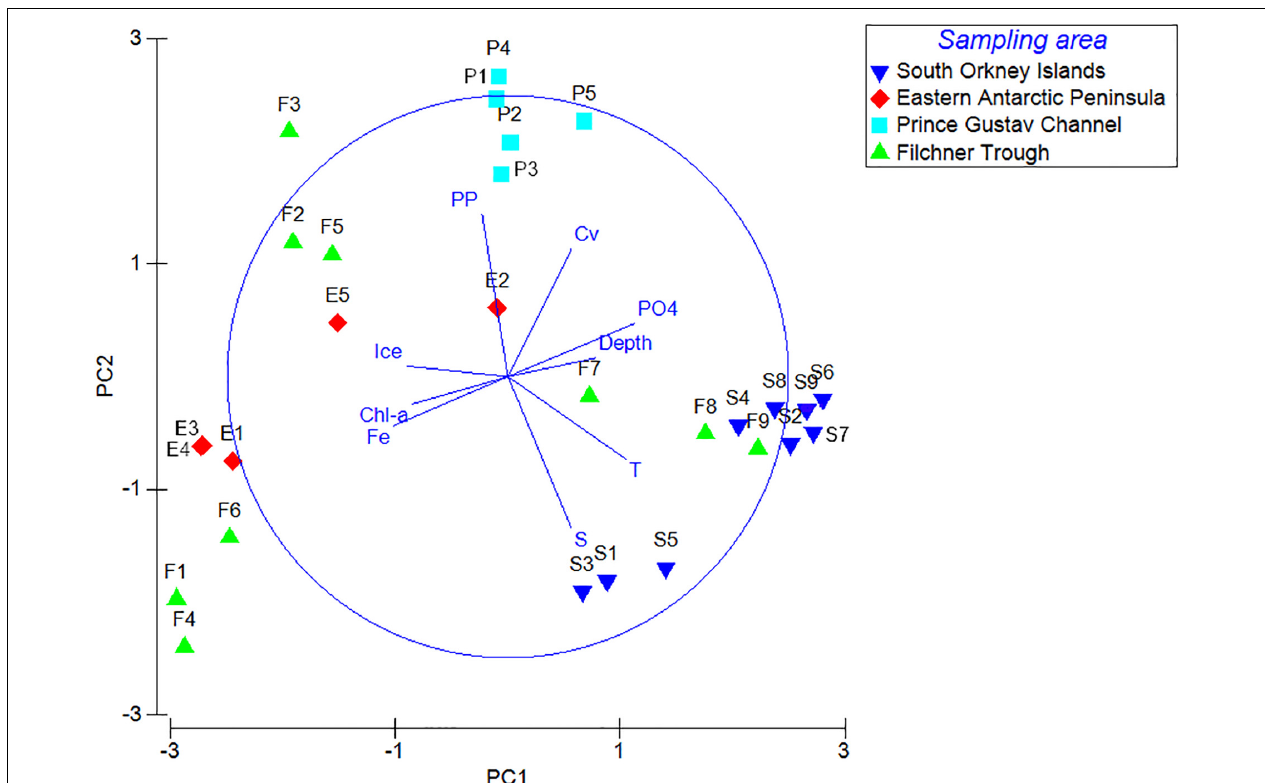
FIGURE 5 | Principal component analysis (PCA) of peracarid assemblages and environmental variables from all stations. PP, primary productivity; Chl, chlorophyll-a; S, salinity; T, temperature; Fe, iron; Cv, current velocity; PO4, phosphate; Ice, ice